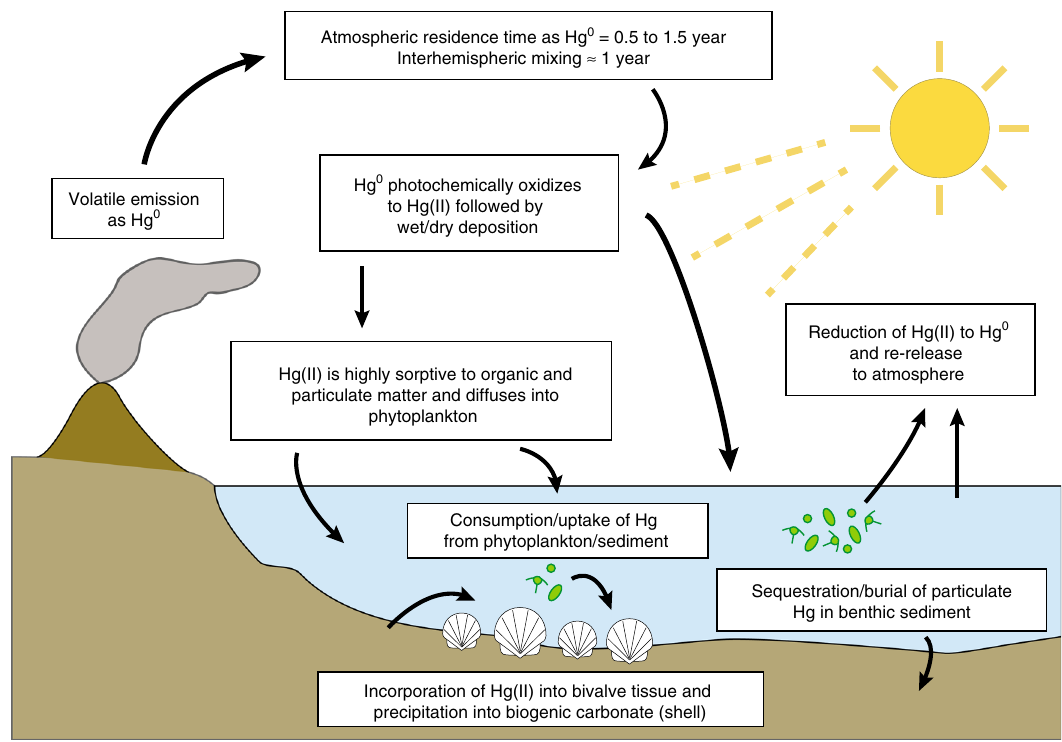
Fig. 1 Conceptual model of volcanogenic Hg emission and subsequent incorporation into marine biota. Gaseous elemental mercury (Hg 0 ) is released in addition to other volatiles (e.g., CO 2 ), where in the atmosphere it is photochemically oxidized to Hg(II) and either adsorbed to particulate and/or organic matter, reduced and rereleased back to the atmosphere, or incorporated into phytoplankton through various uptake pathways. Benthic, sessile, fi lter- feeding marine mollusks can then bioaccumulate Hg(II) from either the consumption of algae or from the sediment directly.